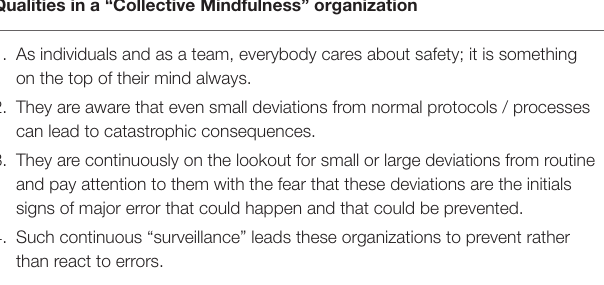
TABLE 3 | Components of Robust Process Improvement.